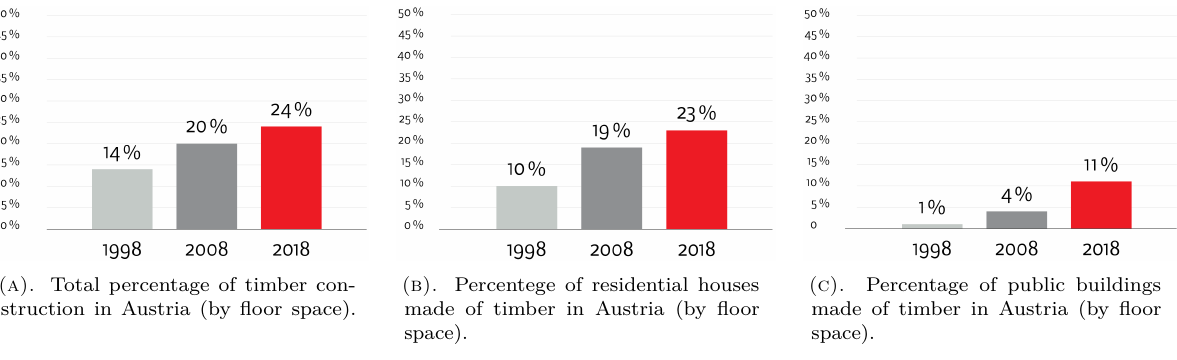
Figure 3. Percentage of timber constructions in Austria [6].